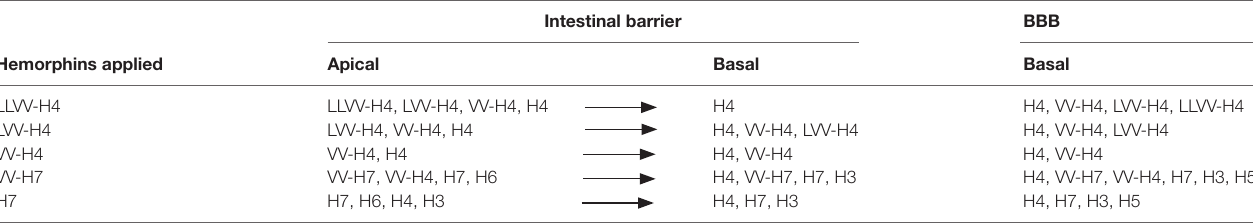
TaBle 1 | Passage of five hemorphins identified in the intestinal fraction of ( in vitro ) gastrointestinal digests of hemoglobin, through the intestinal barrier (IB) (caco-2 model) and blood–brain barrier (BBB) (co-culture model of hematopoietic CD34 + -derived endothelial cells with brain pericytes) in vitro . intestinal barrier BBB hemorphins applied apical Basal Basal